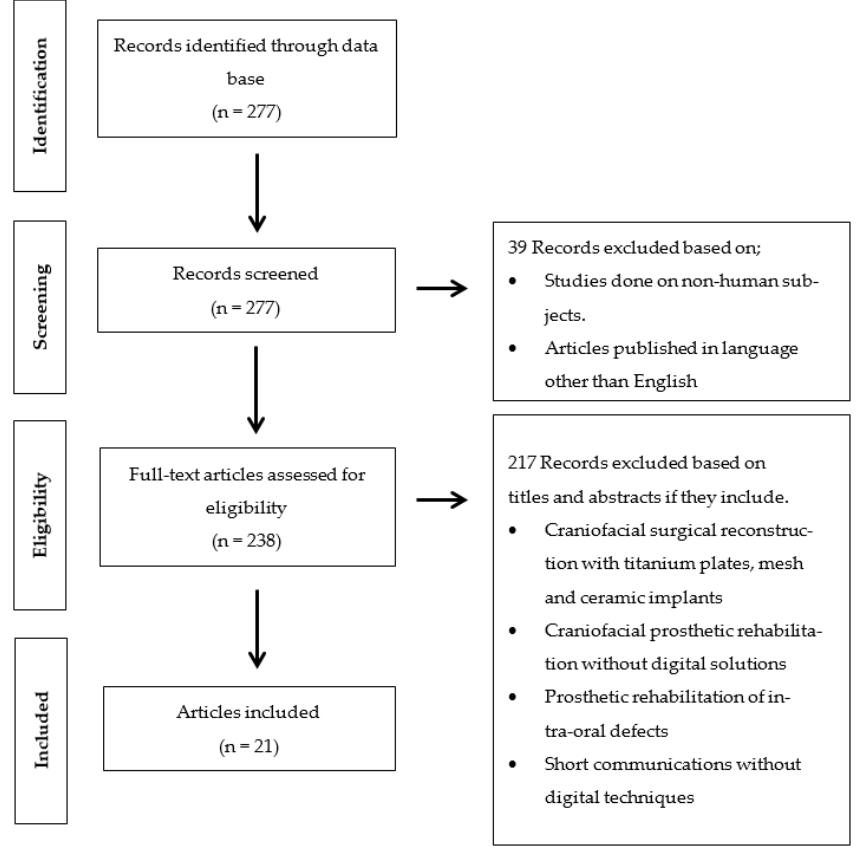
Figure 1. Flow-chart of studies selection process and screening methodology.